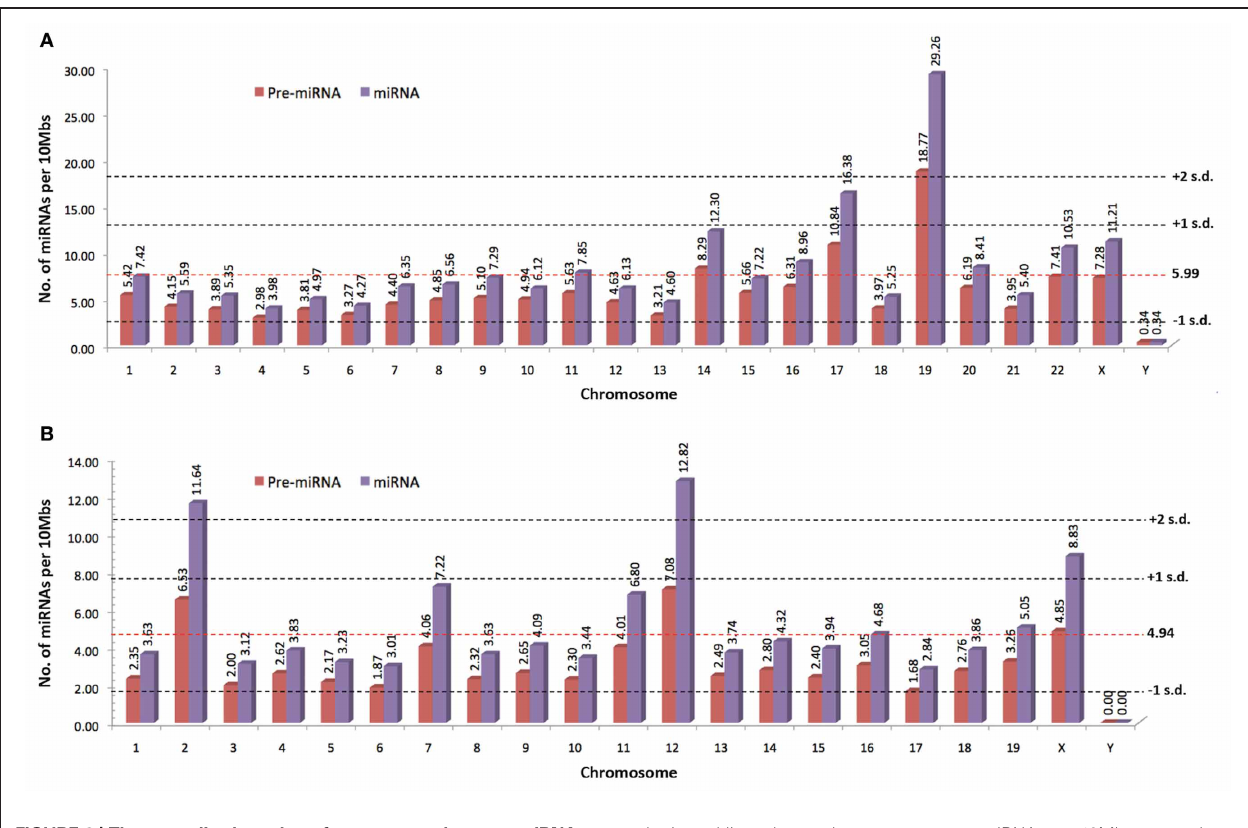
FIGURE 2 | The normalized number of precursor and mature miRNAs per 10Mbs indexed by miRBase for (A) human and (B) mouse (www.miRBase.org; miRBase v19 accessed on 8/11/2012). Red-dotted